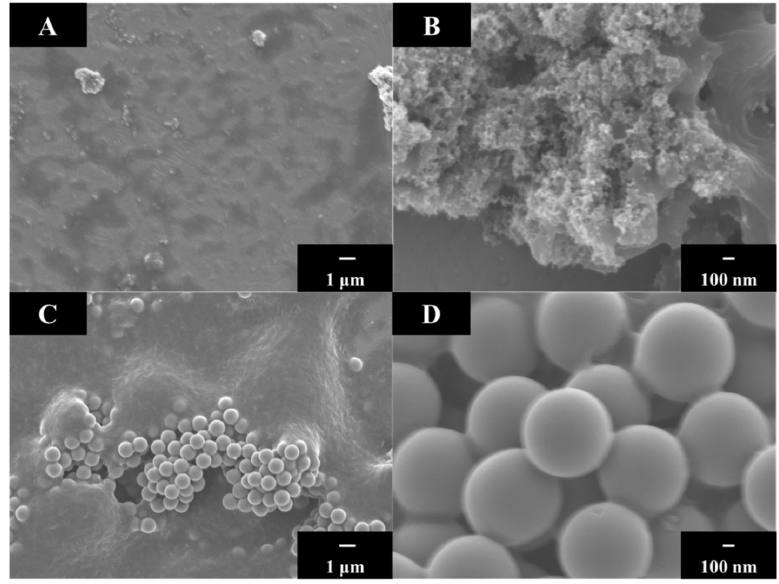
Figure 7. SEM images at different magnifications for coatings deposited from 5 g L − 1 PVDF suspen- sions, containing 1 g L − 1 GA and 1 g L − 1 ( A , B ) nanosilica and ( C , D ) micron-size silica and annealed at 200 °C. Deposition was performed during 5 min at a deposition voltage of 100 V.